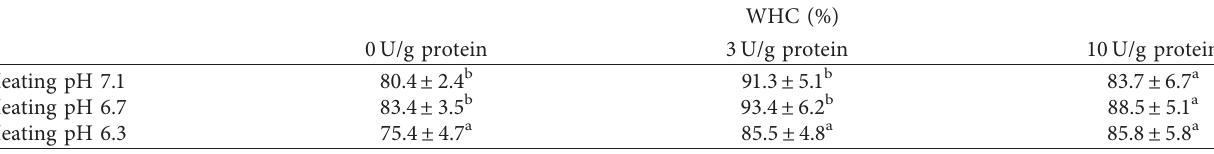
Table 4: Effects of preheating pH and TGase contents on the WHC of acid-induced yak milk